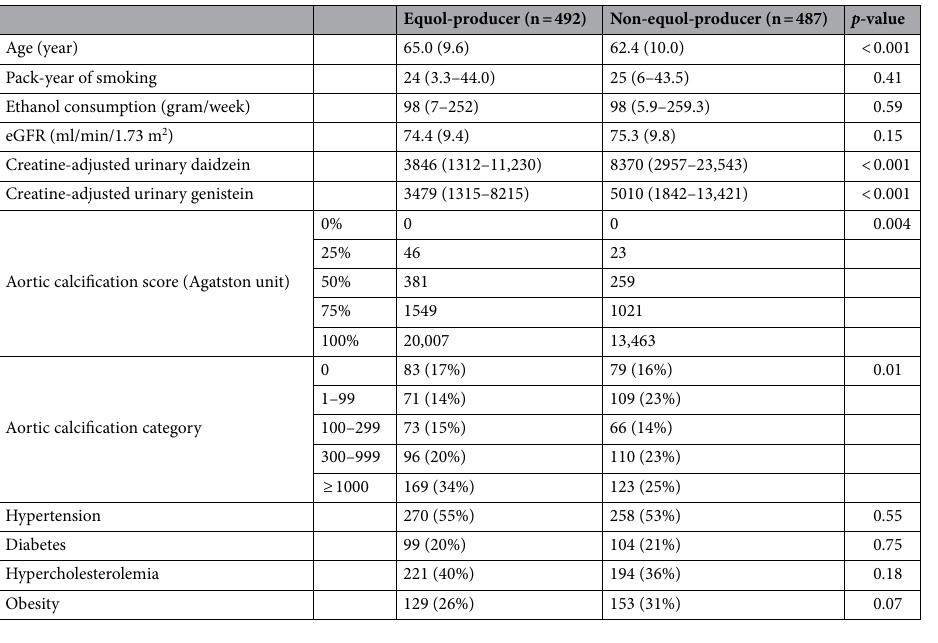
Table 1. Characteristics of analysis sample by equol producing status (n = 979). Mean (standard deviation) is shown if the distribution of a continuous variable is normal; median (25th–75th percentile) is shown if the distribution of a continuous variable is skewed; n (%) is shown for categorical variable. A two-sample t-test was used for normally distributed variables; the Mann–Whitney U test was used for skewed variables; chi- square test was used for categorical variables. eGFR: estimated glomerular filtration rate. Definition: obesity: body mass index ≥ 25 kg/m 2 ; hypercholesterolemia: non-high-density lipoprotein-C ≥ 170 mg/dL or take lipid medicine (non-high-density lipoprotein-C = total cholesterol − high-density